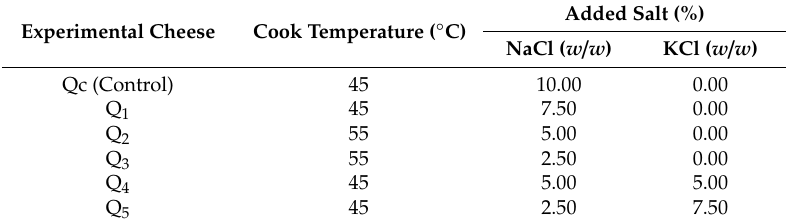
Table 1. Stage drainage of the whey and salting modified during the production of the costeño-type